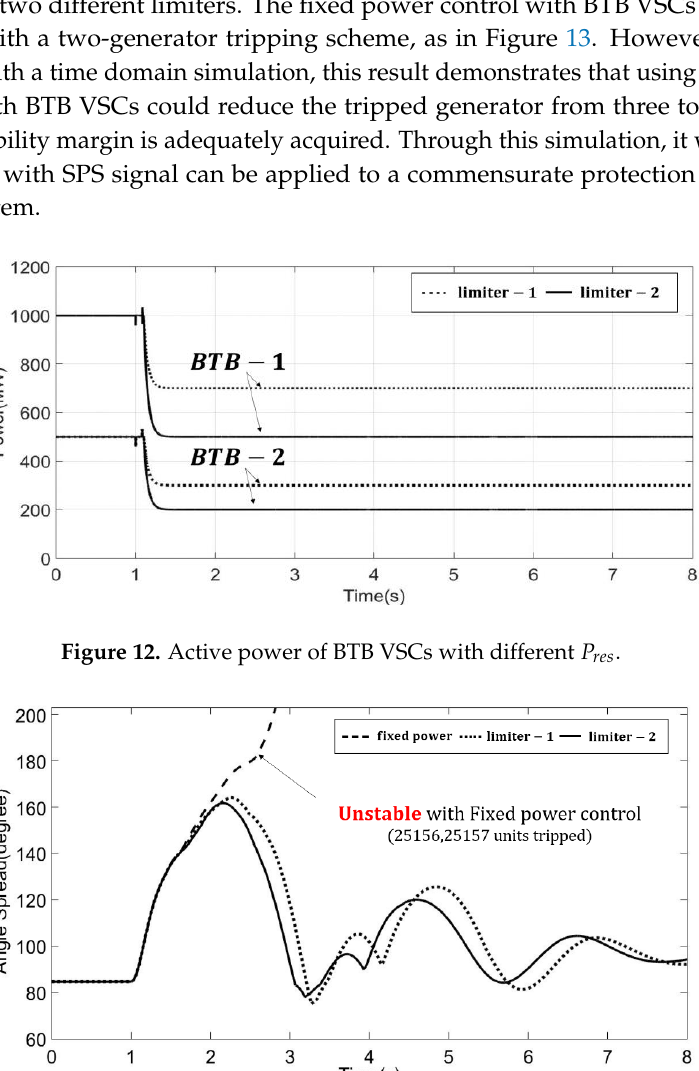
Figure 13. Angle spread result in an N-2 Contingency.